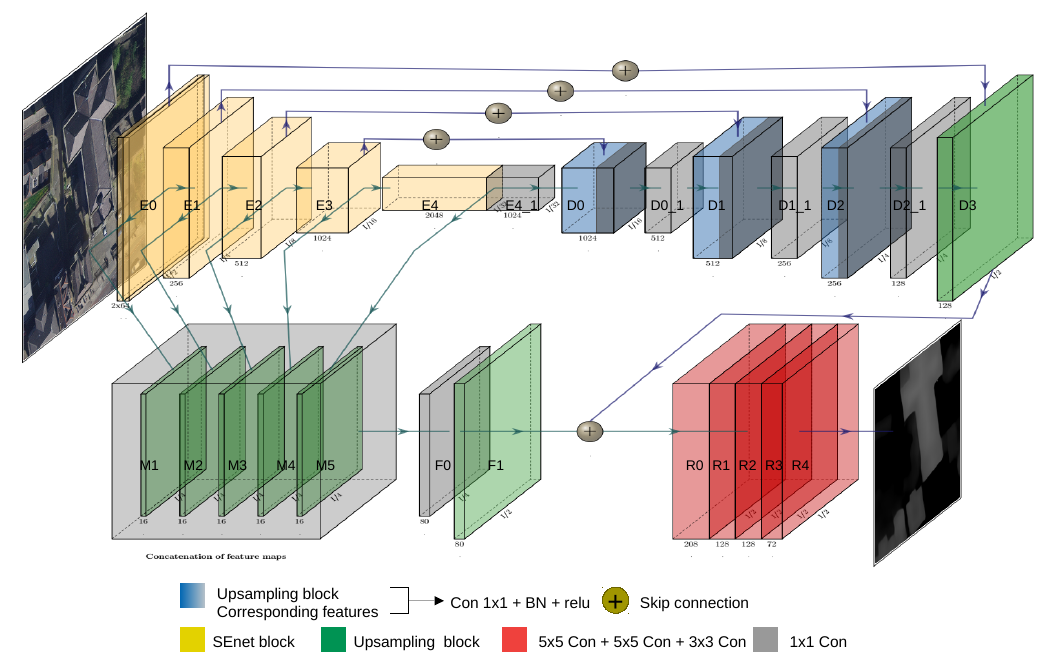
Figure 6. IM2ELEVATION architecture with extra skip connections and postprocessing